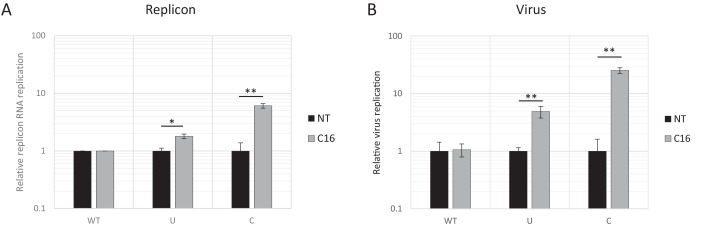
Reduced replication of E7 replicon RNA with increased CpG and UpA dinucleotides is not the result of reduced translation and can be restored by kinase inhibitor C16.RD cells were pre-treated with C16 (2 μM), or left untreated (NT) for one hour prior to E7 replicon transfection (A) or E7 virus infections (B) in appropriate NT or C16 treated media. (A) E7 replicon RNA with ncR1 extensions of either wild type (WT), UpA high (U) or CpG high (C) composition were transfected into RD cells. Firefly luciferase was measured at six hpt. Bars represent the mean of three biological replicates normalized to E7 with ncR1_WT and relative the not treated sample. (B) E7 virus infections (MOI 5) with coding R2 of indicated composition. After 24 hr viral titres were measured in cell culture supernatant in an EPDA. Bars represent the mean of three biological replicates normalized to WT E7 and relative, to the respective NT sample. Error bars represent one standard error of the mean and asterisks indicate significant difference between treatments, p-value *<0.1, **<0.05, T-test.